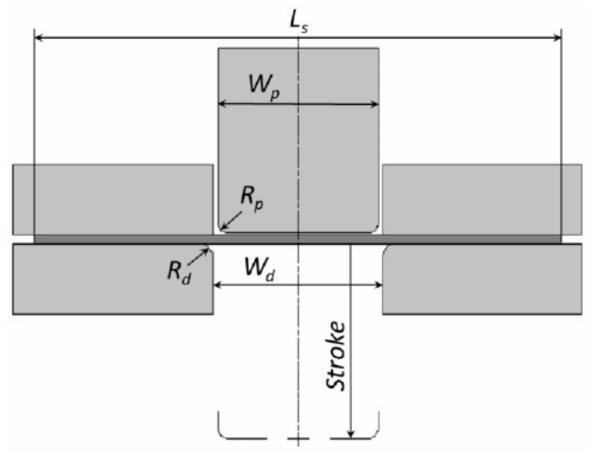
Figure 11. U-drawing test schematic.